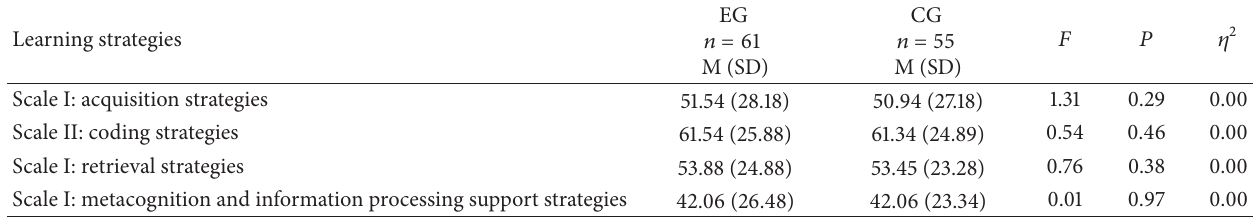
Table 2: Single factor ANOVA of ACRA scales (learning strategies) before (experimental and control program). Learning strategies